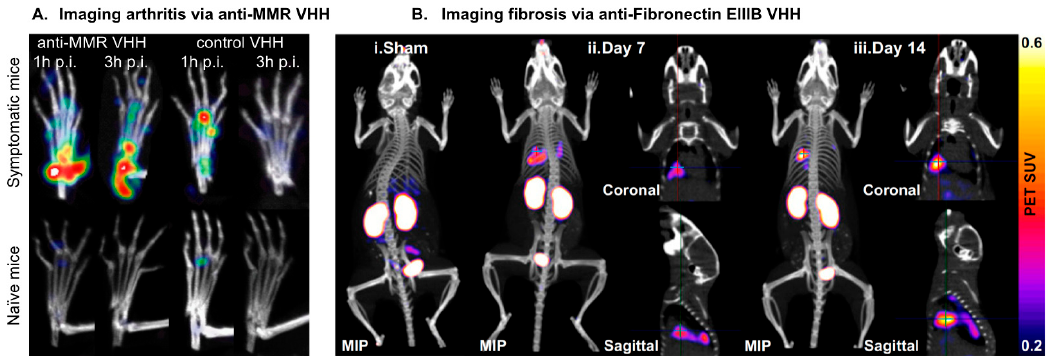
Figure 7. ( A ) Anti-MMR nanobody can be used to detect arthritis in arthritic mice. Images of the affected or healthy limbs were obtained at 1 or 3 h post-injection of 99m Tc-anti-MMR VHH or the BCII10 control VHH (see [128]). ( B ) The 64 Cu-labeled anti fibronectin EIIIB VHH (VHH-NJB2) can detect pulmonary fibrosis in a bleomycin-induced lung fibrosis model with great clarity. The cross-hairs in the sagittal and coronal images show the fibrotic lesions within the lungs. For more details and image quantifications, see [80].